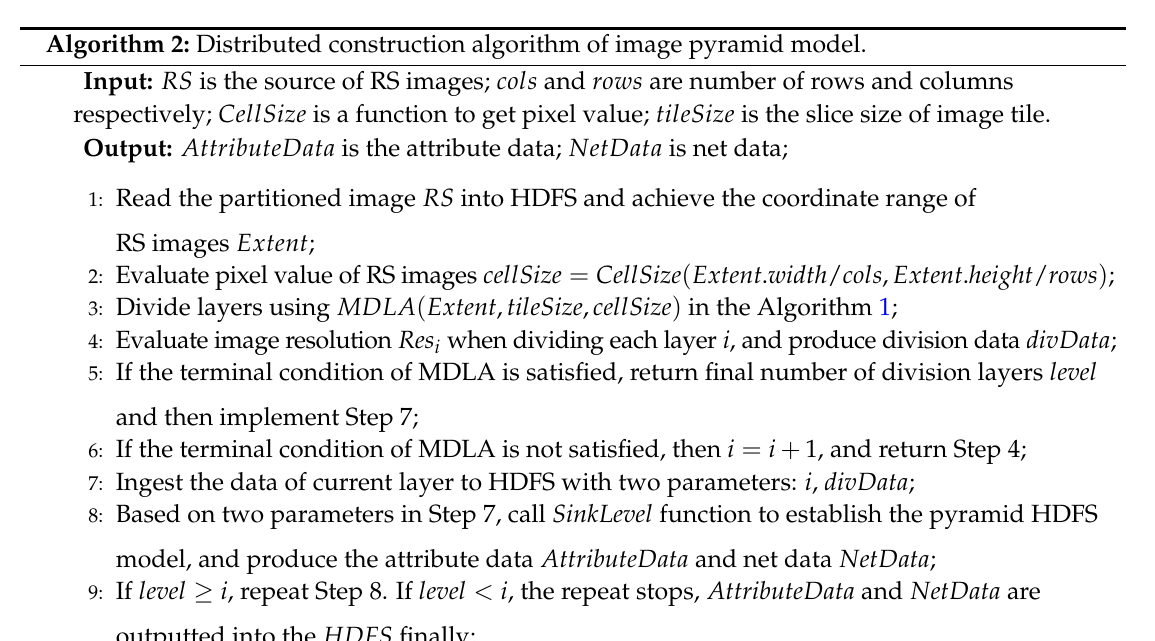
Algorithm 2: Distributed construction algorithm of image pyramid model.